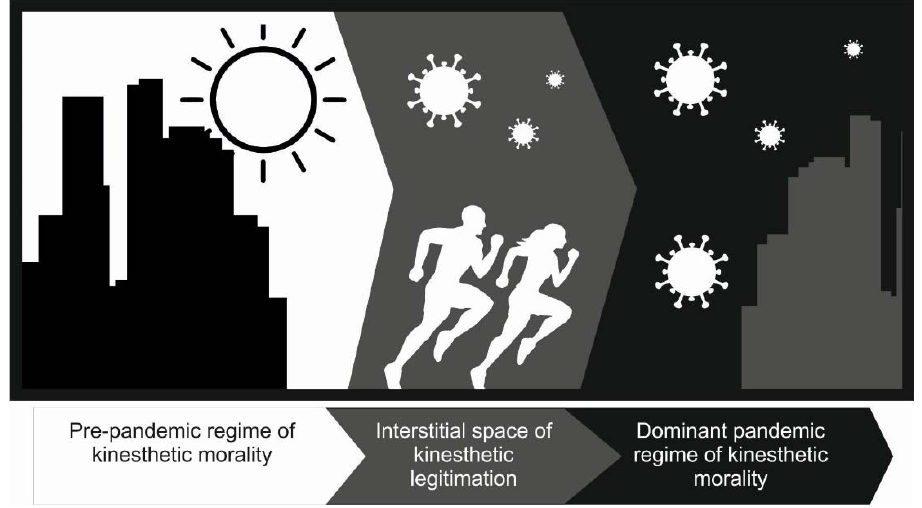
Figure 2. Graphical representation of the sociocultural transformation experienced by the joggers.